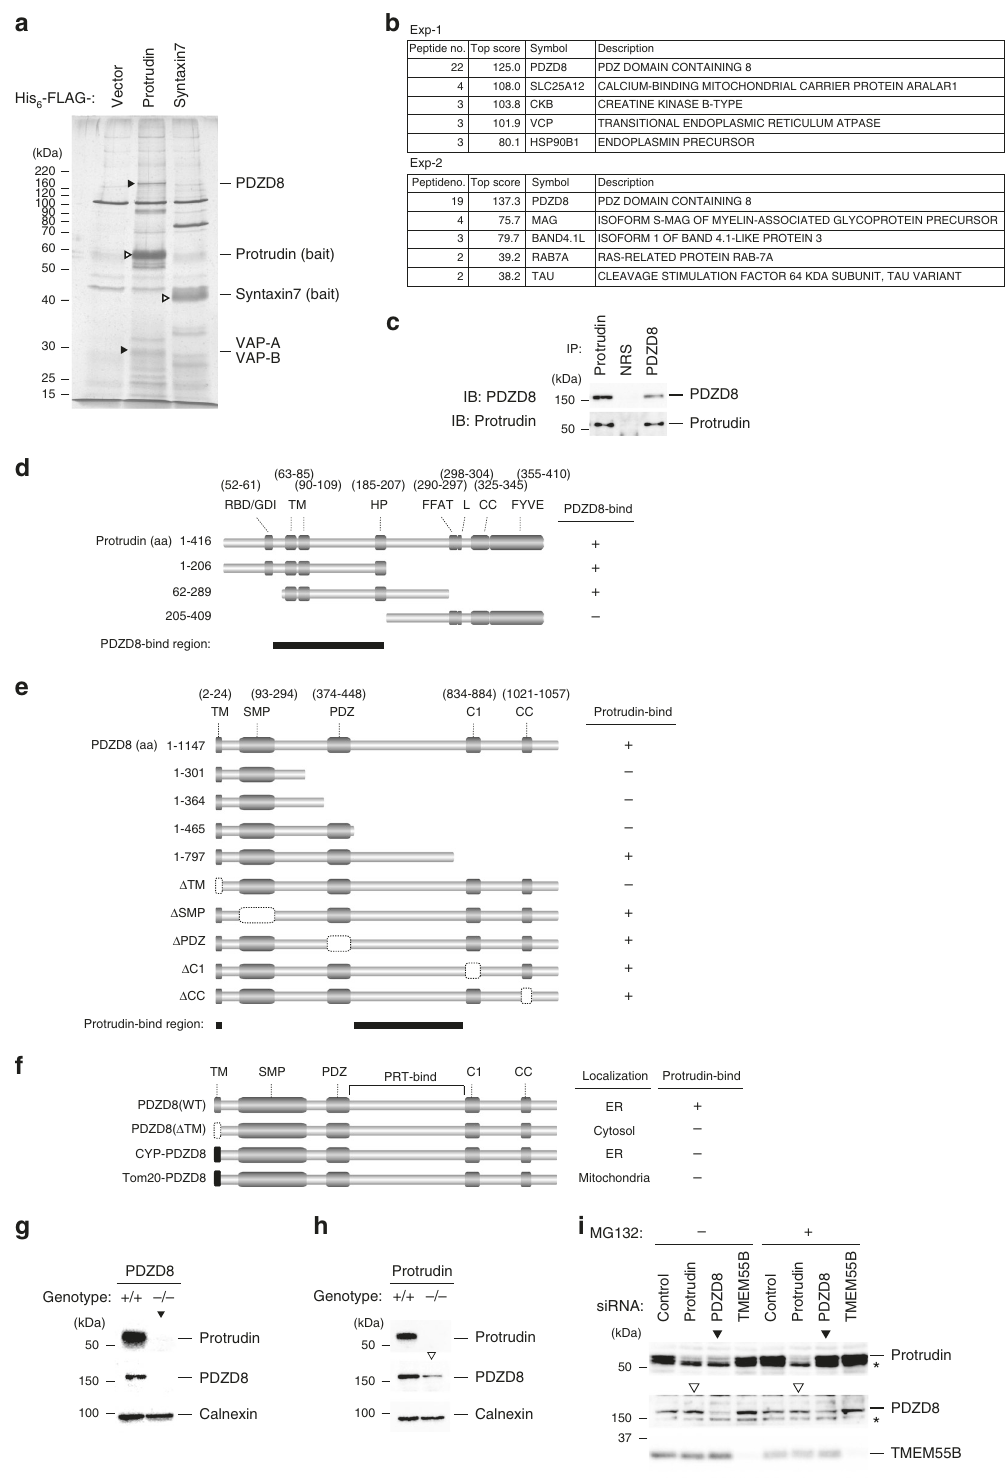
pheochromocytoma cells by small interfering RNA (siRNA)- mediated RNA interference. Knockdown of protrudin mRNA did not affect the abundance of PDZD8 mRNA, and vice versa (Supplementary Fig. 5). On the other hand, depletion of PDZD8 resulted in a reduction in the amount of protrudin at the protein level, with this effect being prevented in the presence of the proteasome inhibitor MG132 (Fig. 1i), suggesting that protrudin NATURE COMMUNICATIONS| (2020) 11:4576